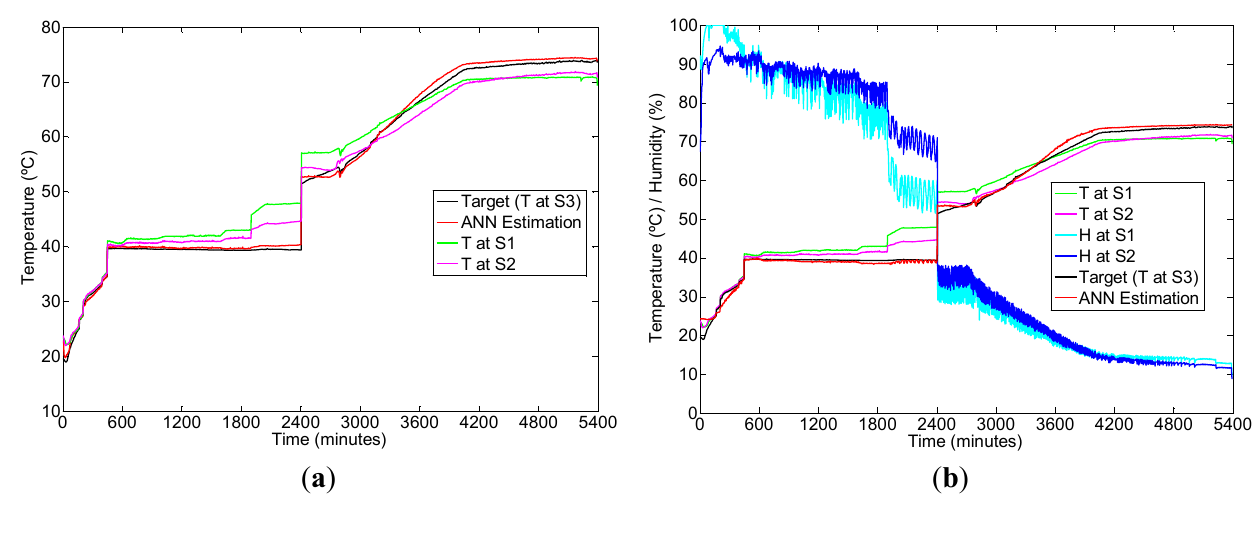
Figure 6. Example of ANN estimation of Temperature (T) at Sensor 3 (S3) for one drying process using Sensors 1 and 2 (S1 and S2) as input. ( a ) Input is only Temperature (T). ( b ) Input combines Temperature (T) and Humidity